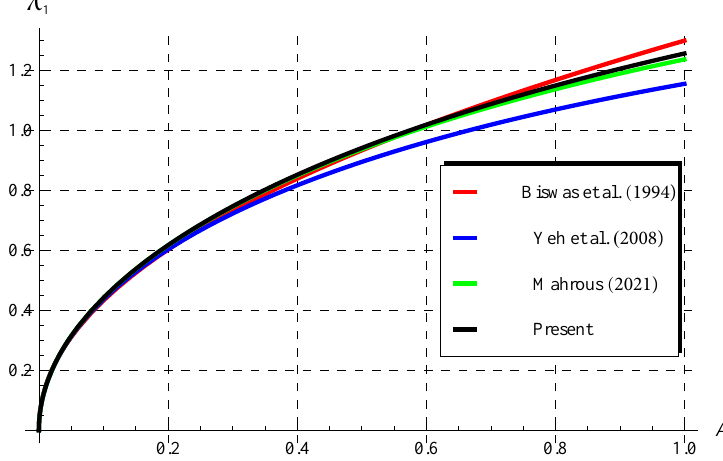
Figure 6. Comparisons between the present numerical and the published approximate values of the first root λ 1 vs. A 2